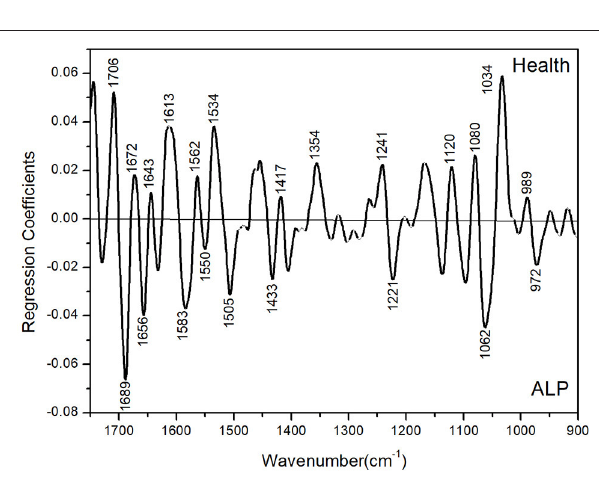
FIGURE 10 | PLS-DA regression coefficient plot in the 1,750–900 cm − 1 spectral